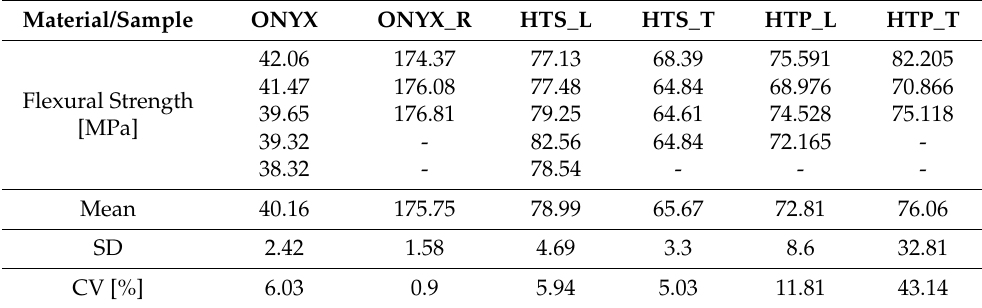
Table 5. Maximum flexural strength